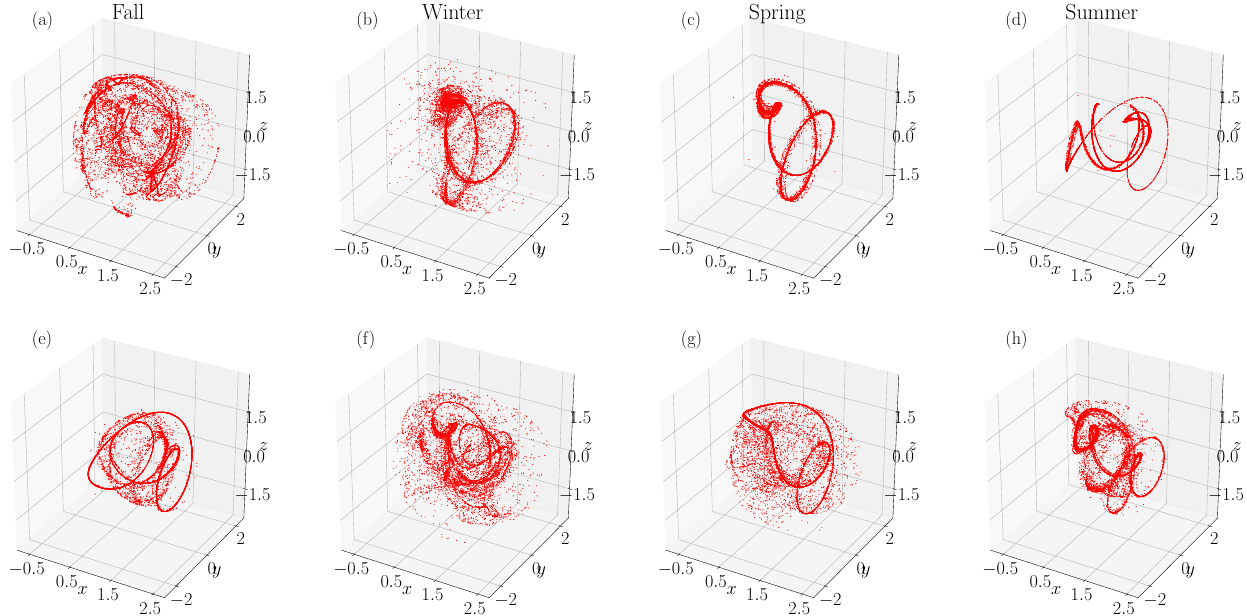
0 years, t 0 . 25 years, = =